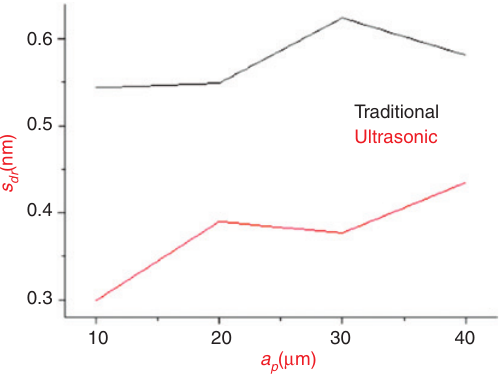
Figure 10: Broken areas: traditional vs. ultrasonic.